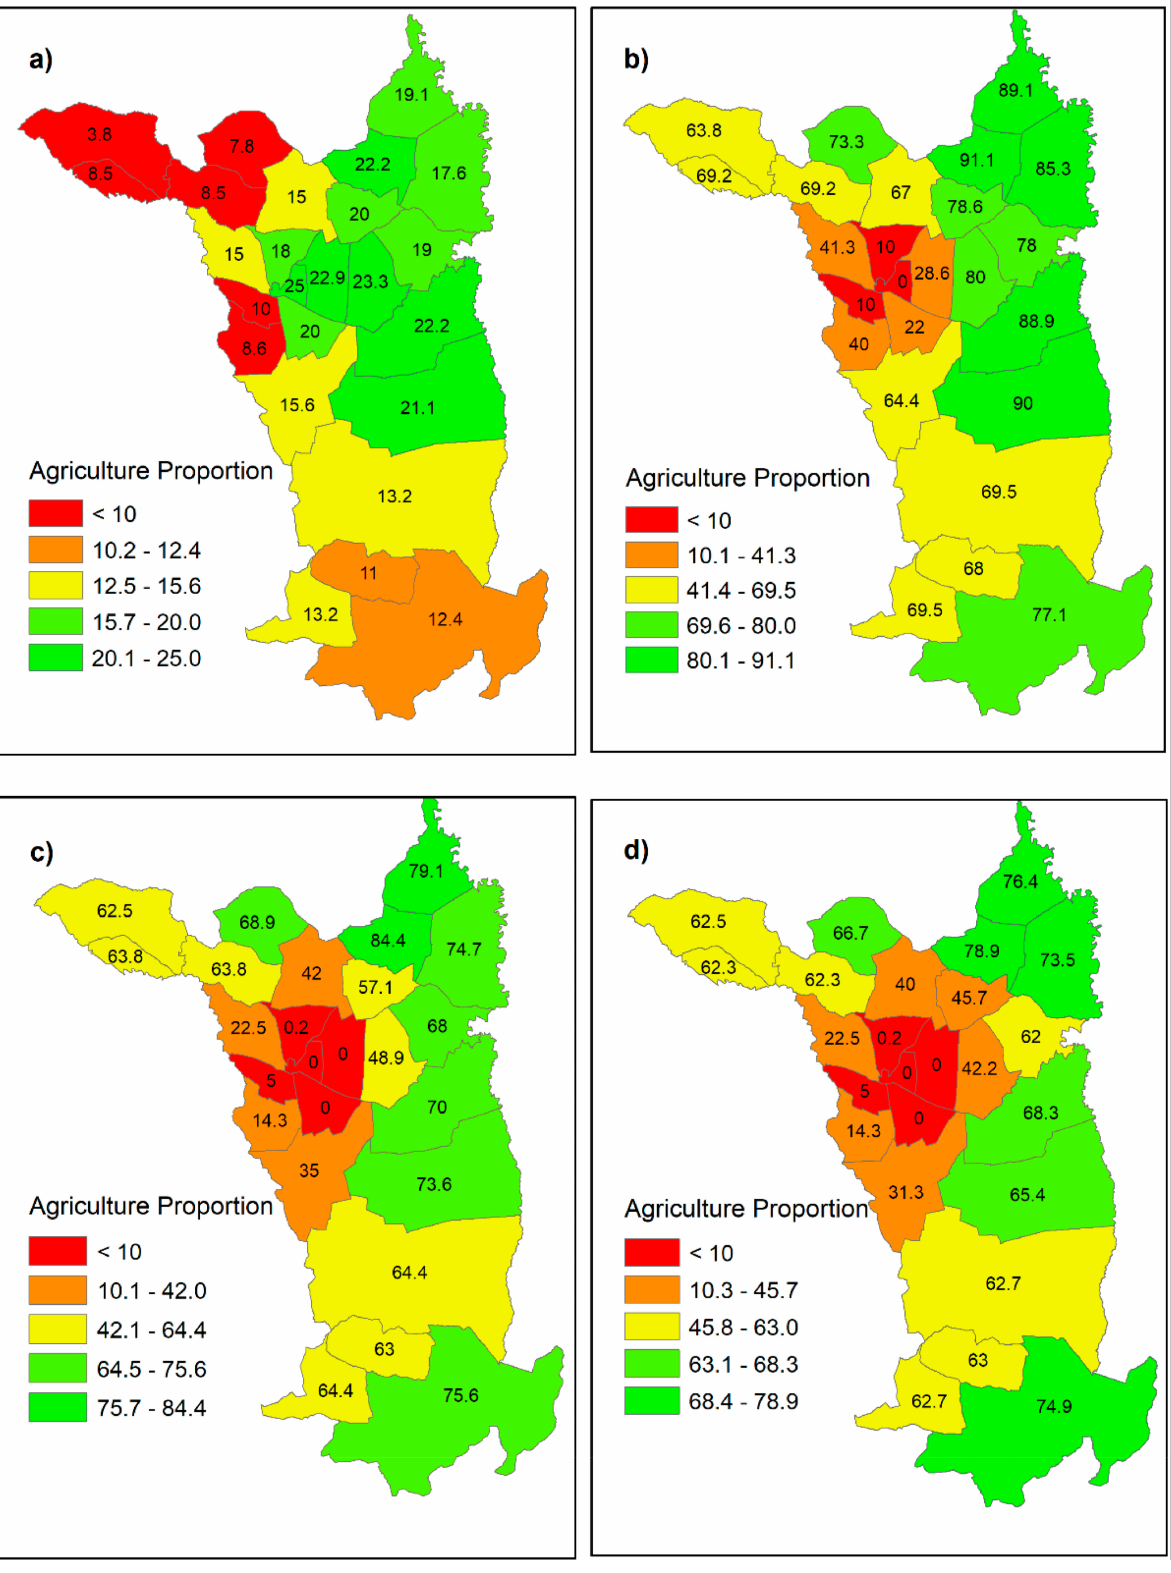
Figure 8. Proportions of agricultural land for the total area of each district in 1972 ( a ), 2000 ( b ), 2015 ( c ), and 2050 ( d